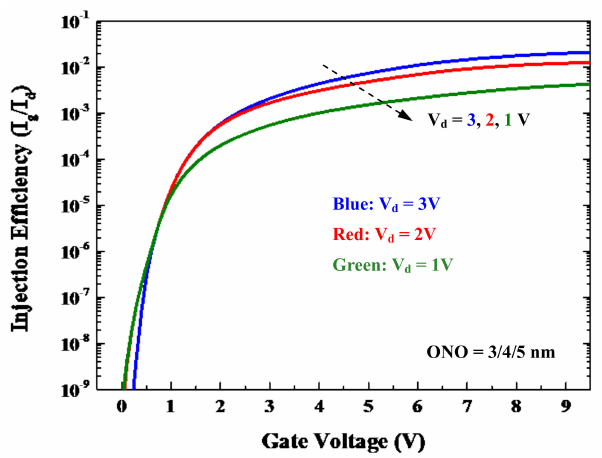
Figure 8. Injection e ffi ciency of scaled double-gate Schottky barrier charge-trapping cells as a function of gate voltage with various drain voltages.